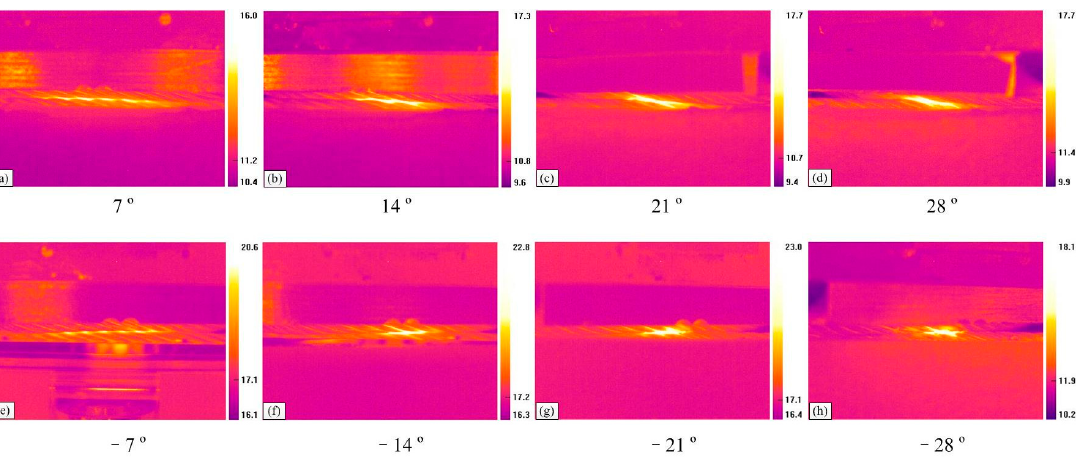
Figure 7. Infrared thermograms for different sliding conditions ( x : 10 mm; v : 6 mm/s). ( a – d ): Right cross contact; ( e – h ): left cross contact.